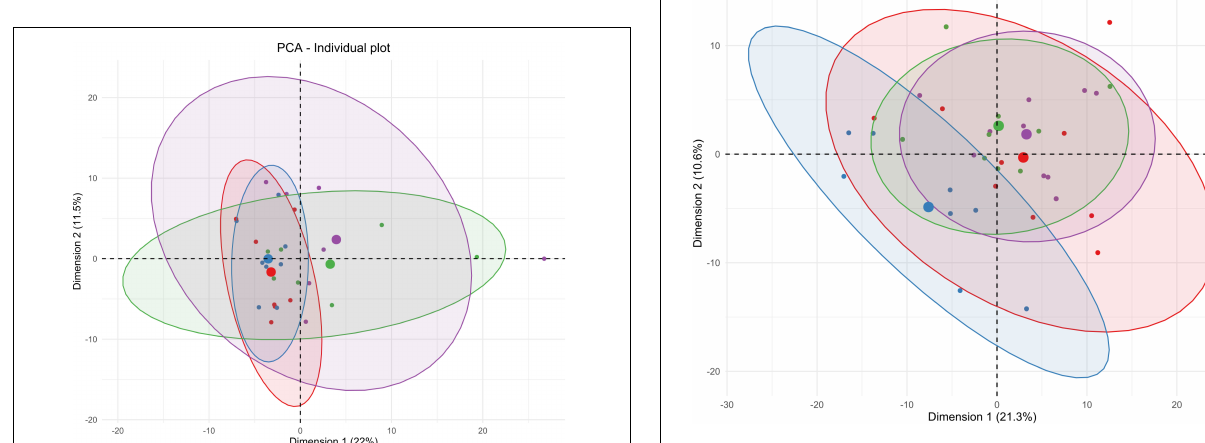
FIGURE 3 | Unsupervised multivariate analyses on striatum metabolome between control and insonified groups. Score plot of principal component analysis (PCA) constructed with metabolites within the striatum metabolome after acoustically-mediated BBB opening (BBBO). Larger dots are inertial centers of ellipses (center of a sample group) plotted based on smaller dots representing each sample individually. Red dots are control samples; Blue dots are 3-h post-BBBO samples; Green dots are 2-days post-BBBO samples; Purple dots are 1-week post-BBBO samples. Two samples having the same metabolic profile will be clustered in the same dimensional space.